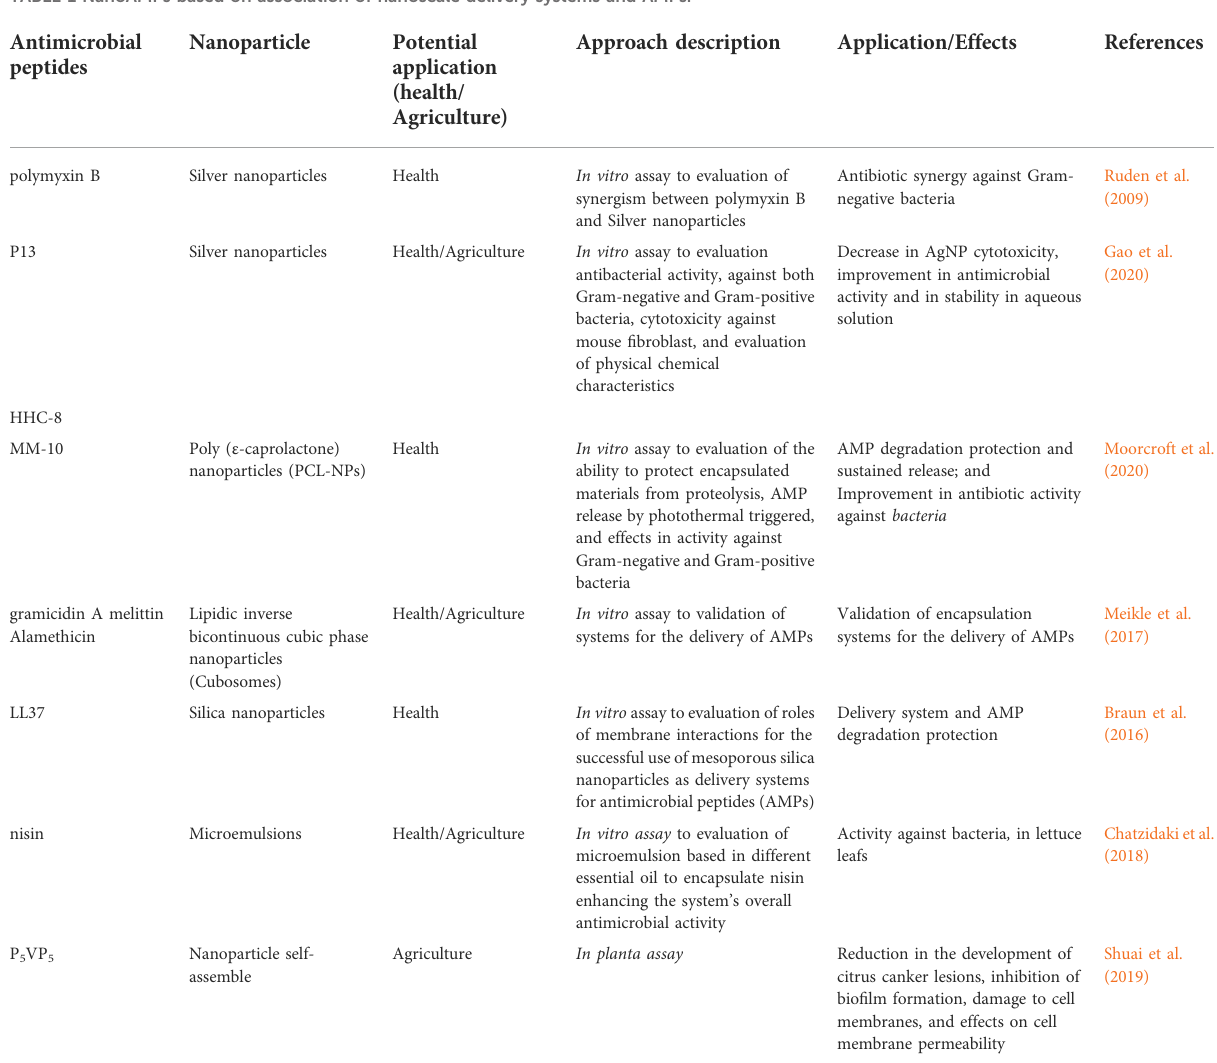
TABLE 1 NanoAMPs based on association of nanoscale delivery systems and